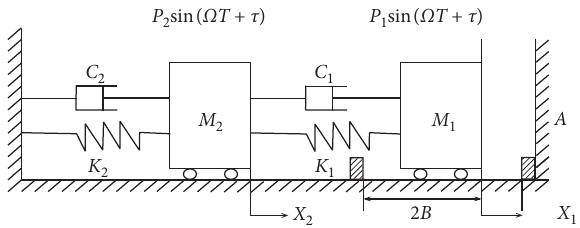
Figure 1: Schematic of the two-degree-of-freedom impact oscil- lator with symmetrical rigid stop A or C . _ X indicates the instantaneous speed at 1 − which the mass M leaves the rigid stop A or C . 1